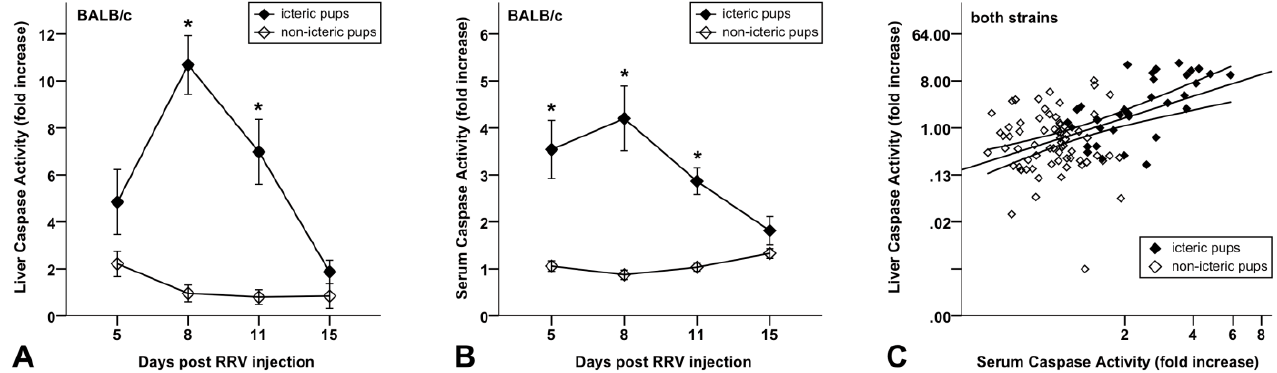
Figure 3. Detection of caspase-3/-7 activity measured using luminescent substrate assay (as fold increase compared to untreated controls; mean ± SEM) in liver tissues ( A ) of 59 icteric and 55 non-icteric and in serum samples ( B ) of 28 icteric and 40 non-icteric BALB/c mice after RRV infection within 24 h of birth. The difference of caspase activity in the liver tissues between both groups is statistically significant (*) at day 8 ( p < 0.001) and day 11 ( p = 0.001) and in serum at day 5 ( p = 0.015), 8 ( p = 0.016) and 11 ( p < 0.001). A positive correlation between caspase activity in liver and serum ( C ) (Pearson’s correlation coefficient 0.687, p < 0.001) shows that caspase activity in serum mirrors apoptosis of the liver in experimental BA mouse model ( p < 0.001).